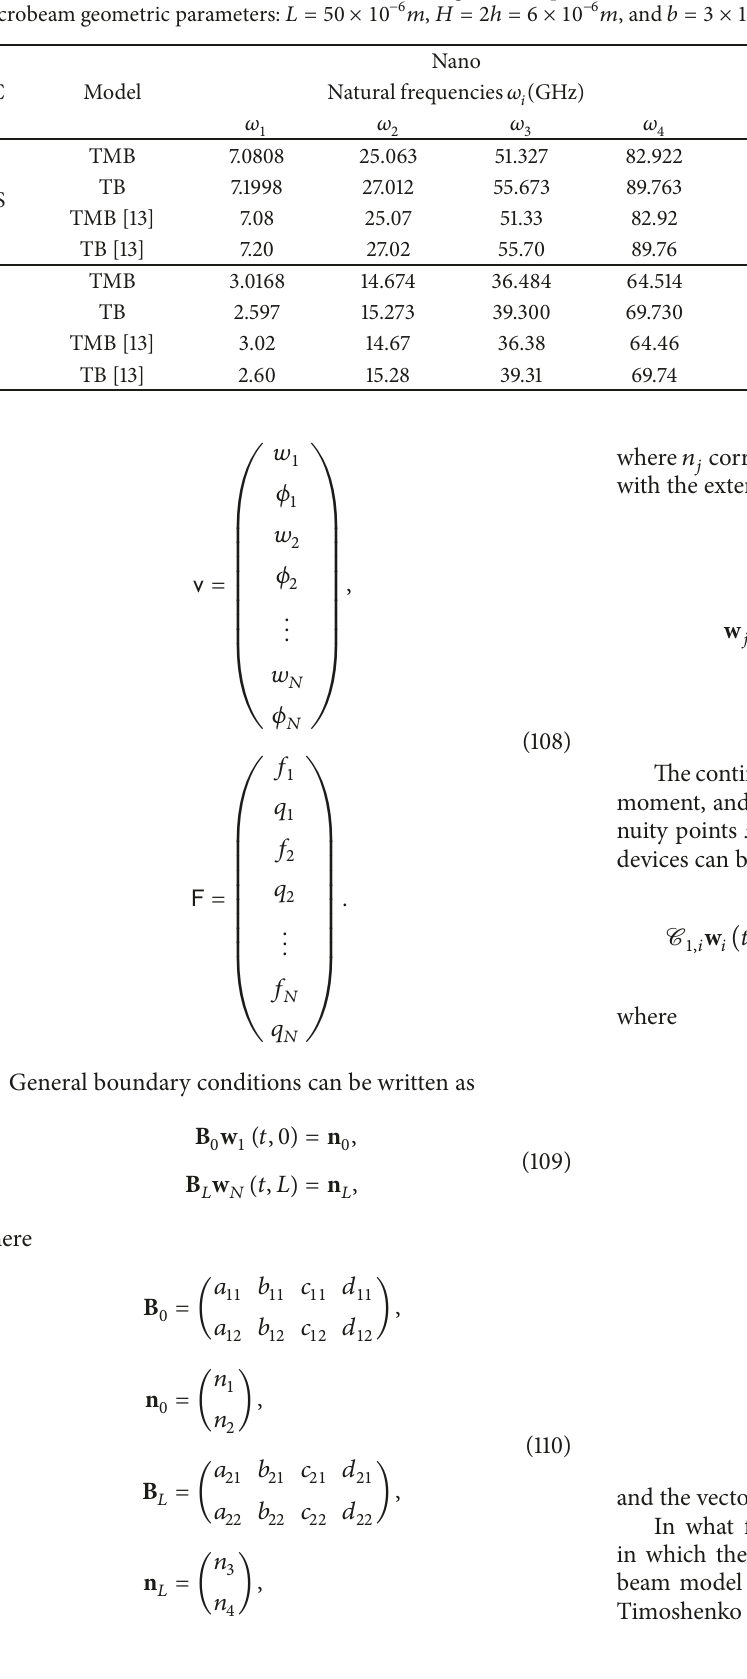
Table 3: Comparison between natural frequencies of Timoshenko beam models including and not including surface effects, considering nano- and microscale, of a Silicon beam. Nanobeam geometric parameters: 𝐿 = 50 × 10 −9 𝑚 , 𝐻 = 2ℎ = 6 × 10 −9 𝑚 , and 𝑏 = 3 × 10 −9 𝑚